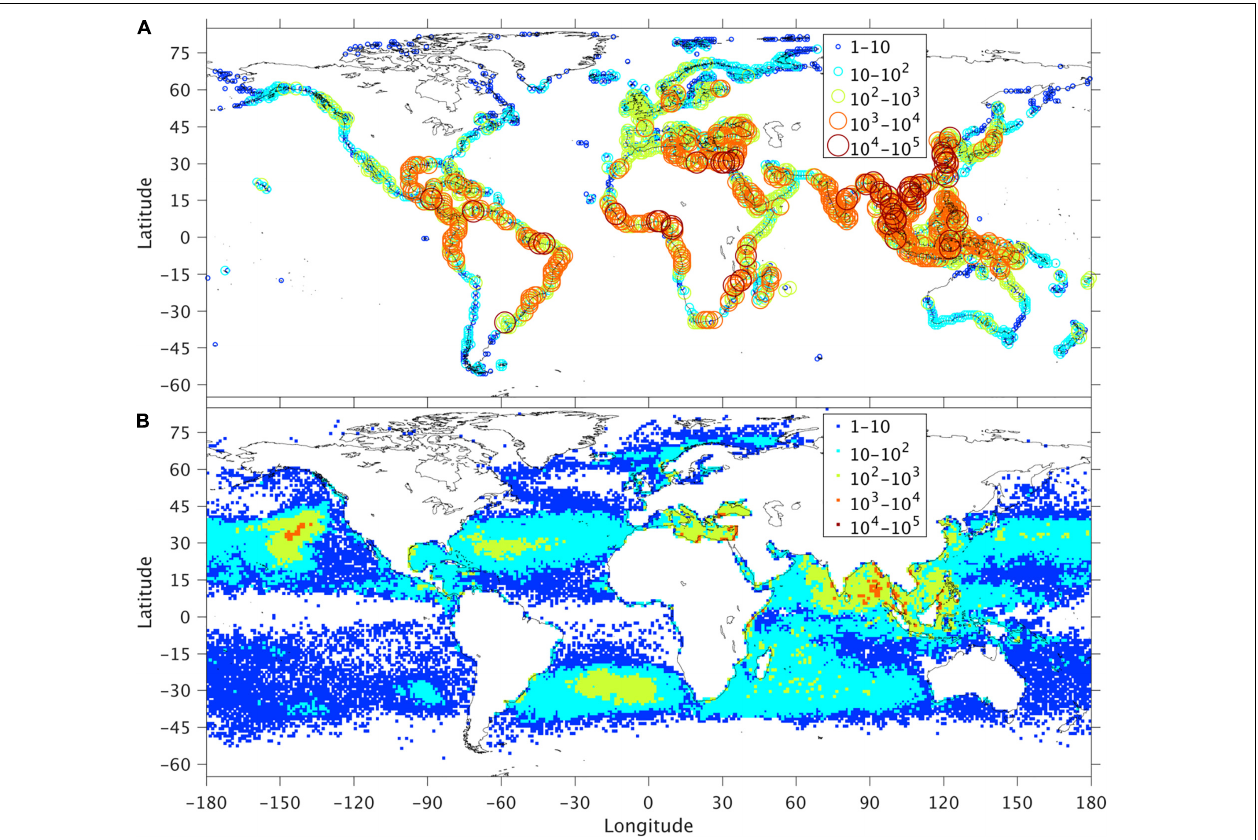
FIGURE 2 | The number of modeled mismanaged plastic waste particles in 1 × 1 ◦ grid box accumulated in 10 years (2010–2019) that are beached (Panel A ) and remain in the water (Panel B ). Out of the total of 3,876,000 released particles, 2,821,752 end up on the beach during the 10-year integration.